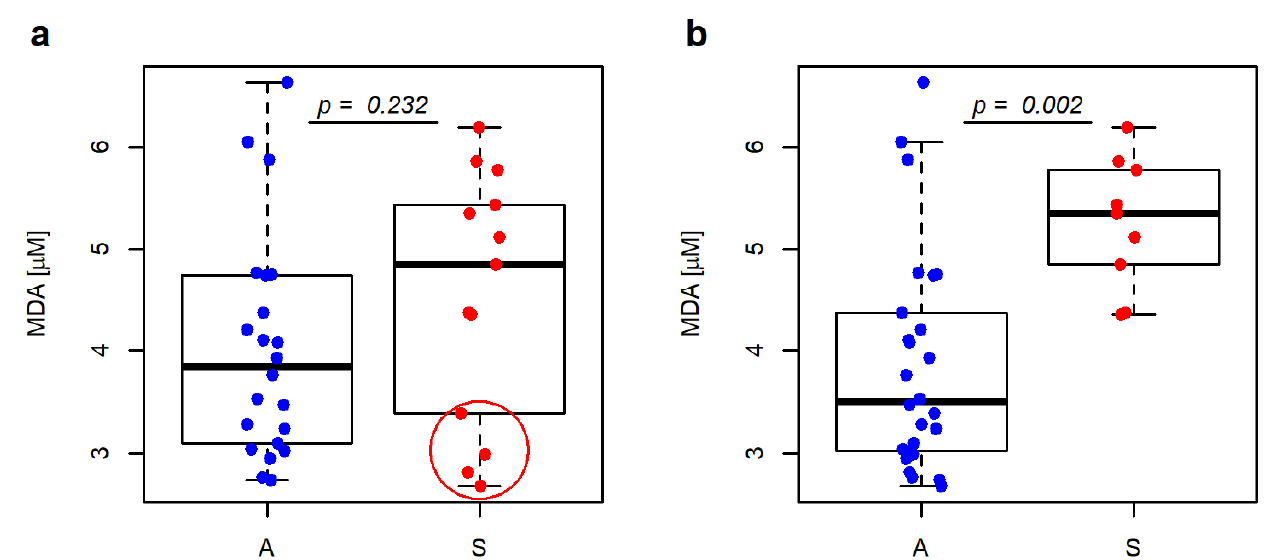
Figure 1. MDA levels are represented as boxplots—( a ) asymptomatic (A—blue dots) and symptomatic (S—red dots) group, patients with AF (in red circle); ( b ) asymptomatic + AF (A) and symptomatic—hemispheric strokes only (S) group. Wilcoxon rank sum test with continuity correction. Vertical boxplots are constructed between the first (Q1) and third (Q3) quartile, with the horizontal median inside. The difference between Q3 and Q1 is called the interquartile range (IQR). Whiskers are drawn from Q1 and Q3 to minimal, respective maximal data points within the range of (Q1 − 1.5 IQR)–(Q3 + 1.5 IQR). Other data are outliers.